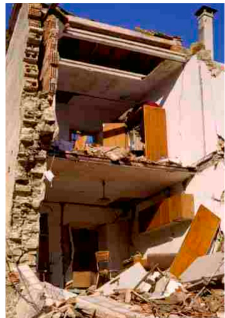
Figure 1. Collapse of a double ‐ layered masonry wall [1].